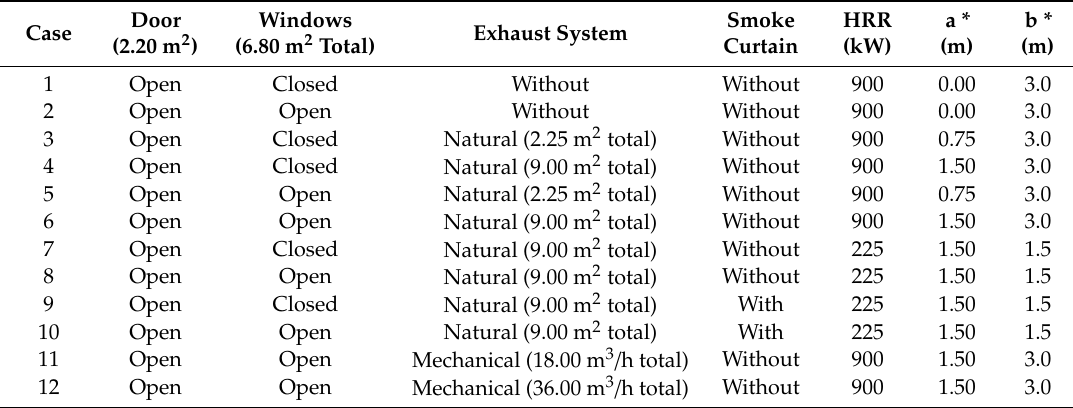
Table 3. Cases studied numerically in this